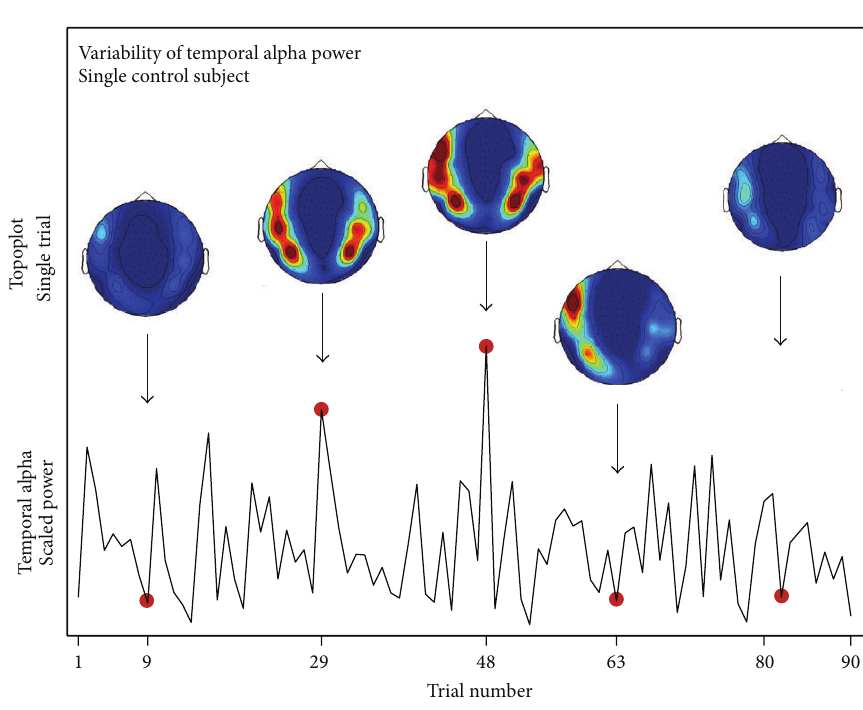
Figure 3: Illustration of the alpha moment-to-moment variability. Data are shown for an example control subject. Bottom: the variability of the temporal alpha activity is shown for the 90 trials. Top: topographical maps are plotted for five selected